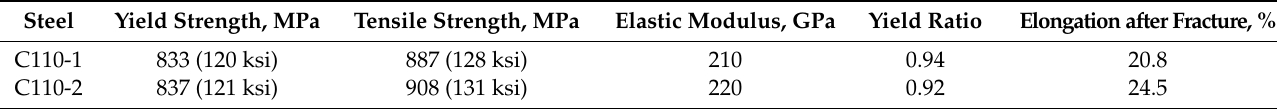
Table 2. Mechanical properties of C110-1 and C110-2.